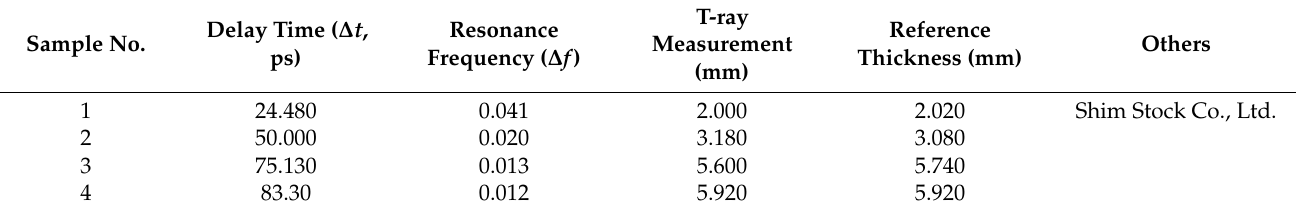
Table 3. Measurements of the GFRP composites with various thicknesses using the THz techniques.